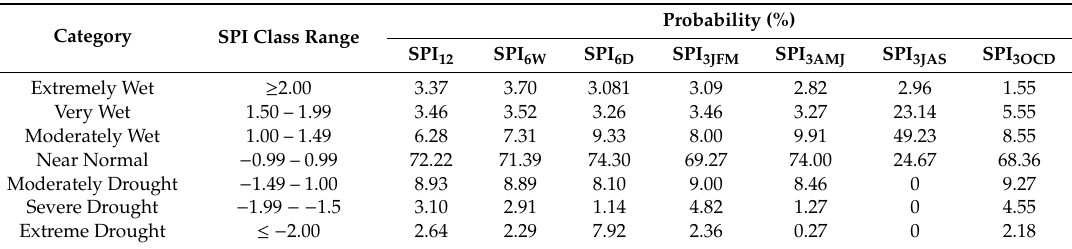
Table3. Theobservedprobabilityforsevencategoriesaccordingtotheannualstandardizedprecipitation index (SPI 12 )